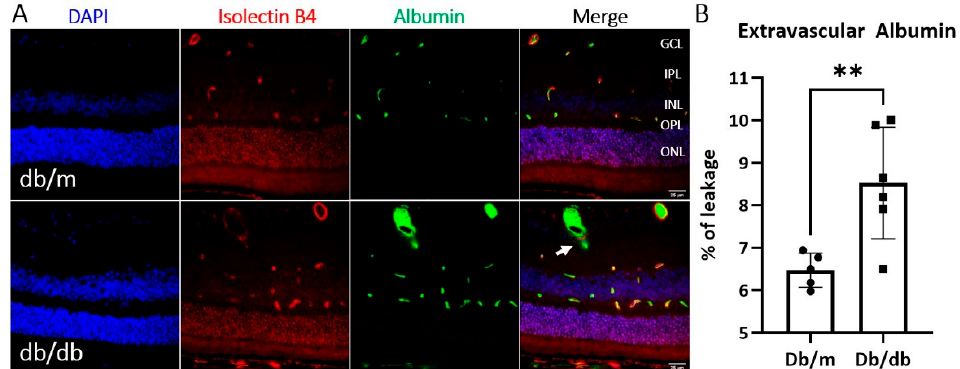
Figure 2. Albumin leakage in db/db and control db/m mice at 3 months of age. Immunostaining for leakage marker albumin and blood-vessel marker isolectin B4 were performed on retinal sections from 3-month old db/db and db/m mice. ( A ) Representative images of DAPI (blue), isolectin B4 (red) and albumin (green) staining in control (db/m) and diabetic (db/db) mice, n ≥ 5 animals per group. Arrow indicating extravascular albumin. GCL—ganglion cell layer; IPL—inner plexiform layer; INL—inner nuclear layer; OPL—outer plexiform layer; ONL—outer nuclear layer. ( B ) Quantification of albumin extravasation. Mean ± SD, ** p < 0.01, by unpaired t -test. Having shown BRB leakage in three-month-old db/db mice, we then examined pJAK1 expression in the neuroretinas of db/m and db/db mice (Figure 3). Indeed, elevated pJAK1 levels were found in the neuroretinas of db/db mice compared to db/m mice (Figure 3).